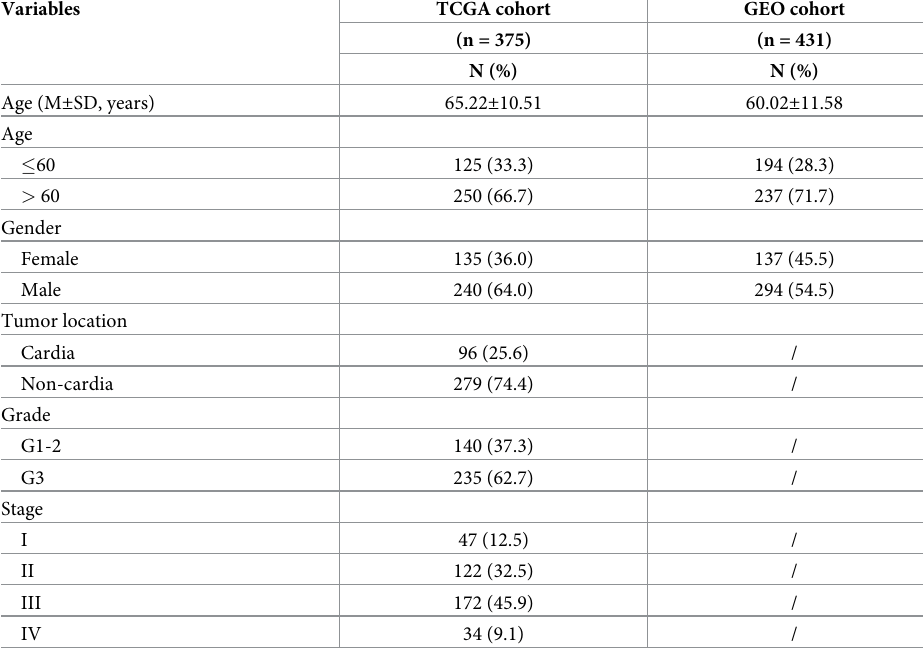
Table 1. Clinicopathologic characteristics of gastric cancer patients in TCGA and GEO